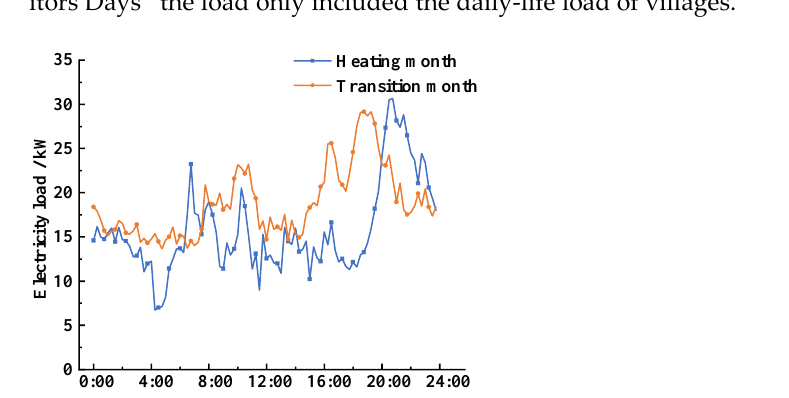
Figure 6. Minimum daily load curves in a heating month and a transition month.